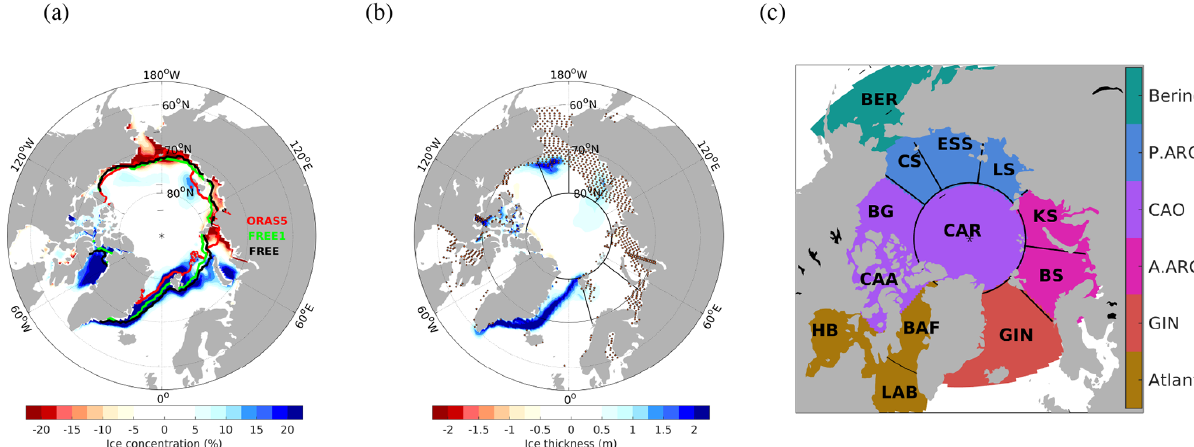
Figure 2. Model bias with respect to ORAS5 (REF) on 1 November for the period 1979–2014 for the single-member FREE1. (a) SIC. Colour lines indicate the September sea ice extent (15% SIC) climatology for ORAS5 (red), FREE1 (green) and FREE (black). (b) SIT with dots indicating a mask for area with water depth < 100m where no SIT initialization is applied. The maps have the bounding latitude at 56 ◦ N. Blue areas represent regions with more SIC and SIT in the model than REF, reflecting cold bias in surface temperature. (c) Regions considered for Arctic sea ice. Atlantic MIZ (brown): Hudson Bay (HB), Baffin Bay (BAF) and the Labrador Sea (LAB); the GIN seas (red); Atlantic Arctic (pink): Barents Sea (BS) and Kara Sea (KS); central Arctic Ocean (CAO, purple): central Arctic (CAR, 80 ◦ N north), Canadian Archipelago (CAA) and Beaufort Gyre (BG); Pacific Arctic (blue): Laptev Sea (LS), East Siberian Sea (ESS) and Chukchi Sea (CS); Bering Sea (BER,